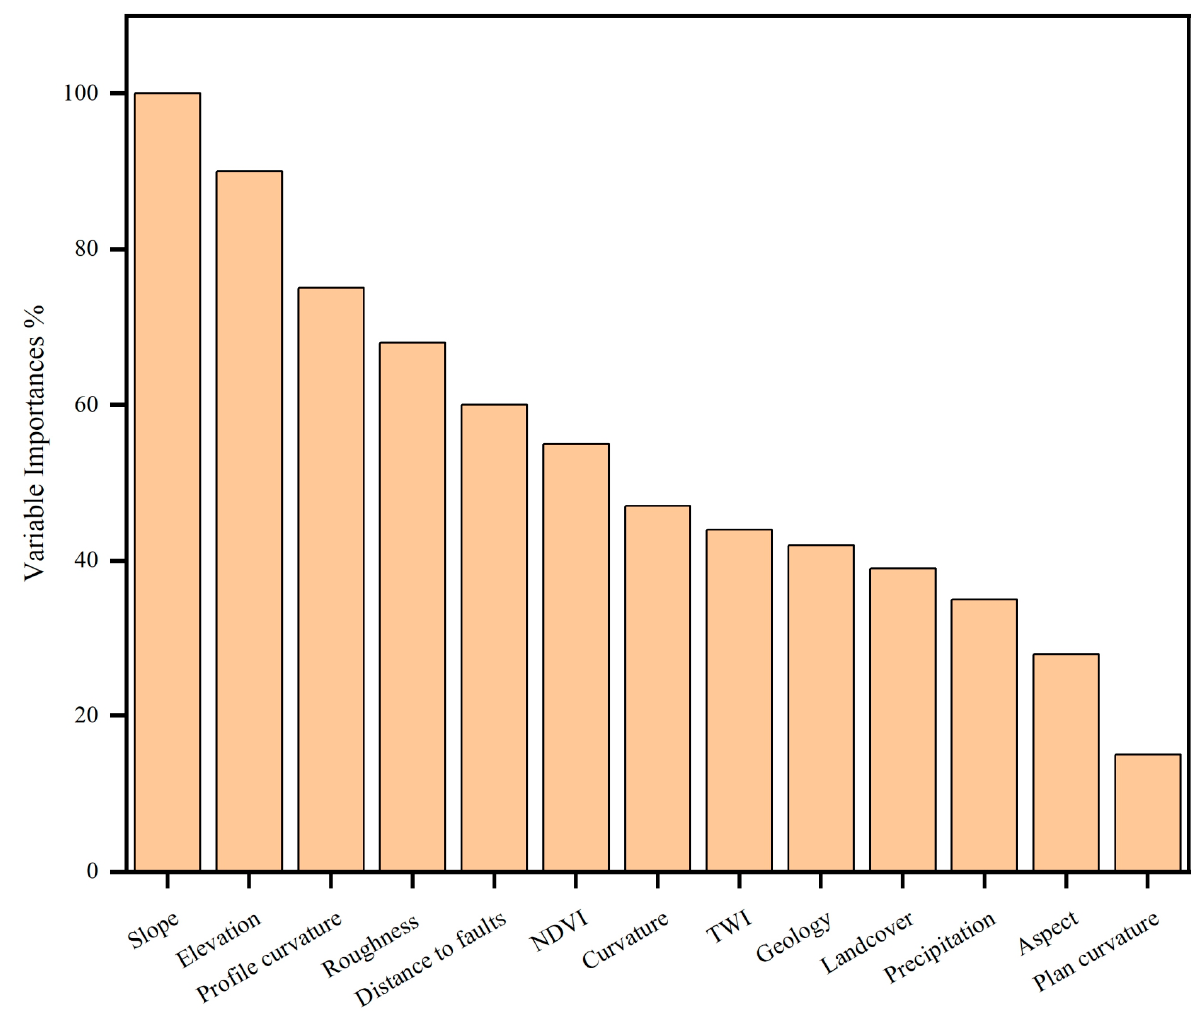
Figure 8 . Factors important in the research region using the RF model. Figure 8. Factors important in the research region using the RF